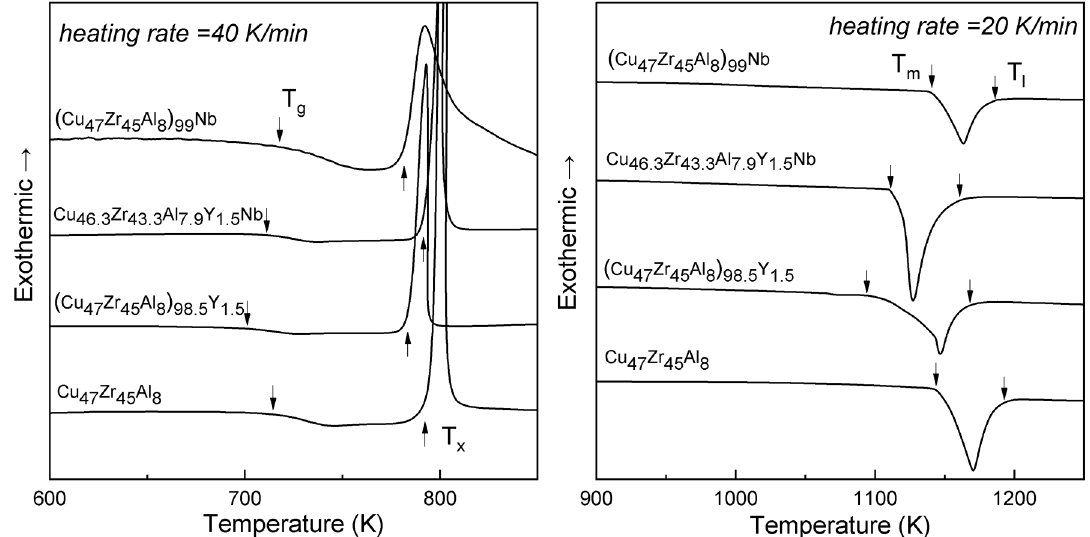
Figure 1. DSC and DTA curves of several relevant compositions of Cu-Zr-Al systems. of several compositions of Cu-Zr-Al system Table 1. Thermodynamic parameters and D c